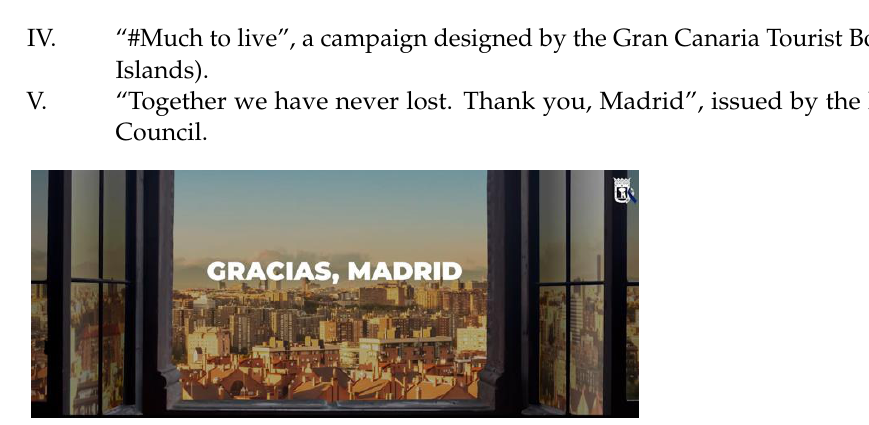
Figure 5. Capture of the campaign “Together we have never lost. Thank you, Madrid” . Table 5. Campaign analysis “Together we have never lost. Thank you, Madrid” . We present the results below (see Tables 1–5). Brand Region brand, which represents the city of Madrid; “ Pedestal mark. ” Table 1. Analysis of the campaign “Spain Awaits